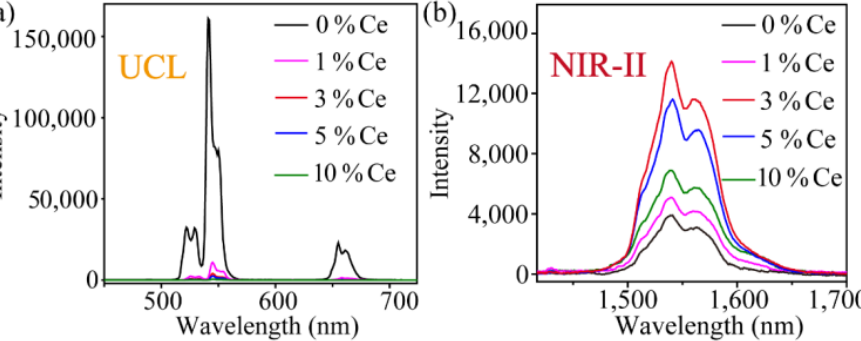
Figure 3. ( a ) Upconversion luminescence spectrum and ( b ) NIR-II luminescence spectrum of NaYF 4 :20%Yb,2%Er,x%Ce (x = 0, 1, 3, 5, 10) nanoparticles (dispersed in cyclohexane). The NaYF 4 :Yb,Er,Ce@SiO 2 -OAlg and OAlg have similar characteristic peaks, in